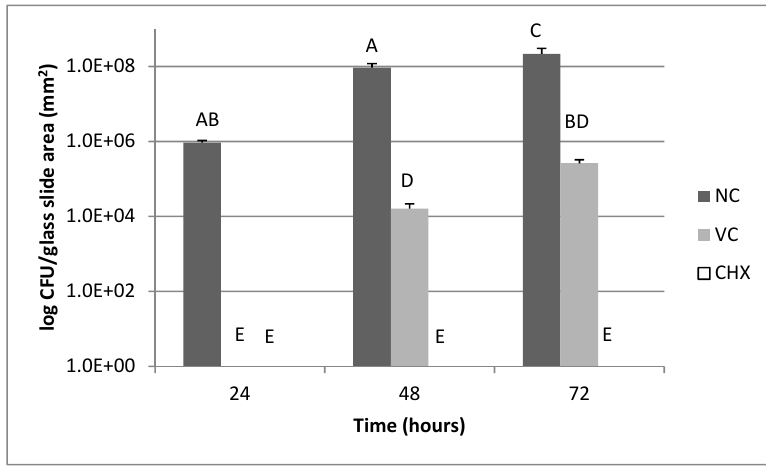
Figure 2. Bacterial viability of P. gingivalis biofilms according to treatments. NC= negative control (without exposure to formulation); VC= vehicle control; CHX= chlorhexidine-based chitosan formulation. Data expressed as mean ± standard deviation in logarithmic scale ( n = 6). Values that do not share the same letter (A, B, C, D, E) are significantly different from each other; Shapiro – Wilk test followed by Tukey – Kramer post-hoc test, p < 0.05.